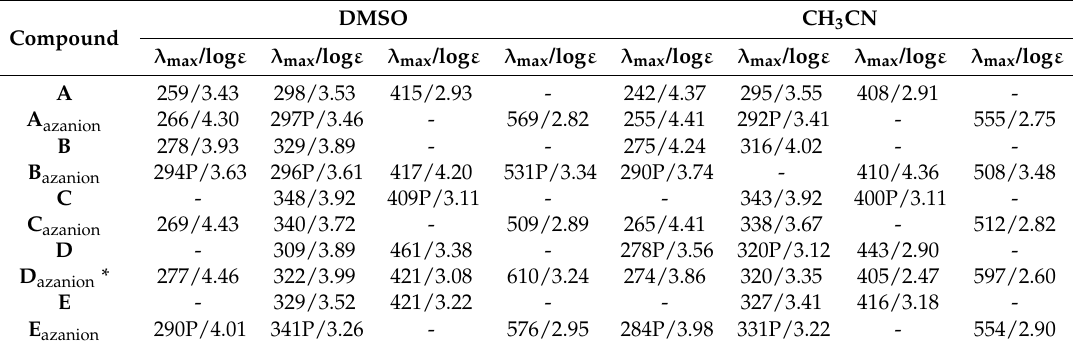
Table 1. UV–Vis spectra of A – E and their azanions (1 × 10 − 4 mol · dm − 3 ) in DMSO and CH 3 CN. DMSO CH 3 Compound